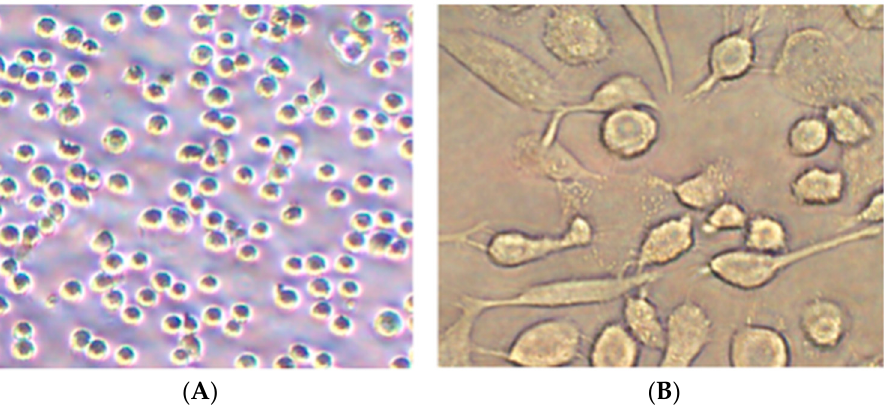
Figure 1. Morphology of THP-1 cells ( A ) before and ( B ) after differentiation.